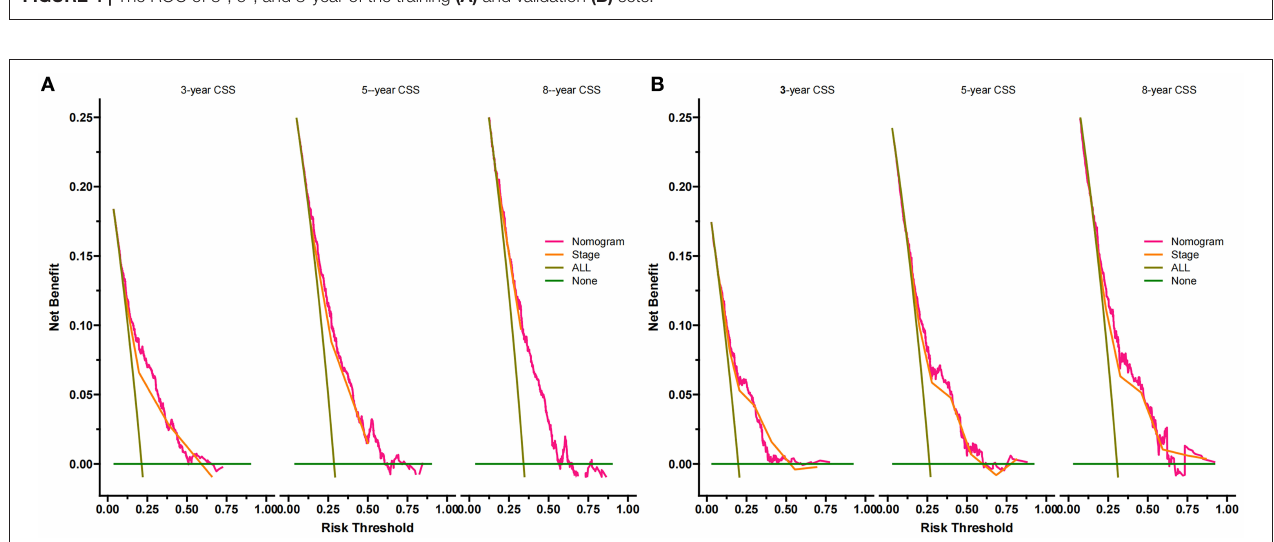
FIGURE 4 | The ROC of 3-, 5-, and 8-year of the training (A) and validation (B) sets.